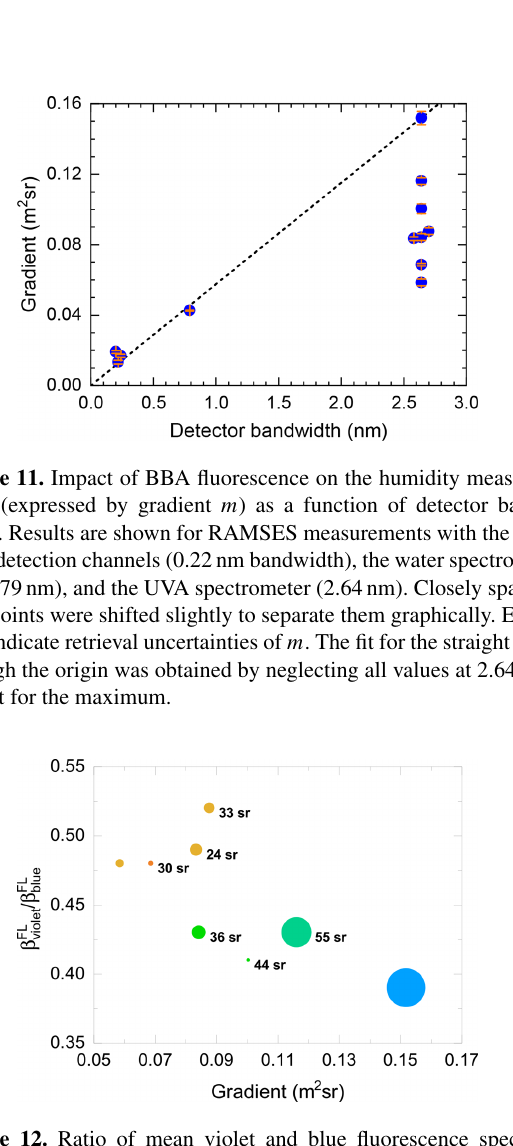
Figure 12. Ratio of mean violet and blue fluorescence spectral /β FL backscatter coefficients ( β FL ) as a function of gradient ( m ). violet blue Only measurements with the UVA spectrometer are considered. To visualize the relation to atmospheric temperature and particle op- tical properties, the data points are colored and sized according to ambient temperature and particle depolarization ratio, respectively, and particle lidar ratios are given as labels (when available). For numerical values, see Table